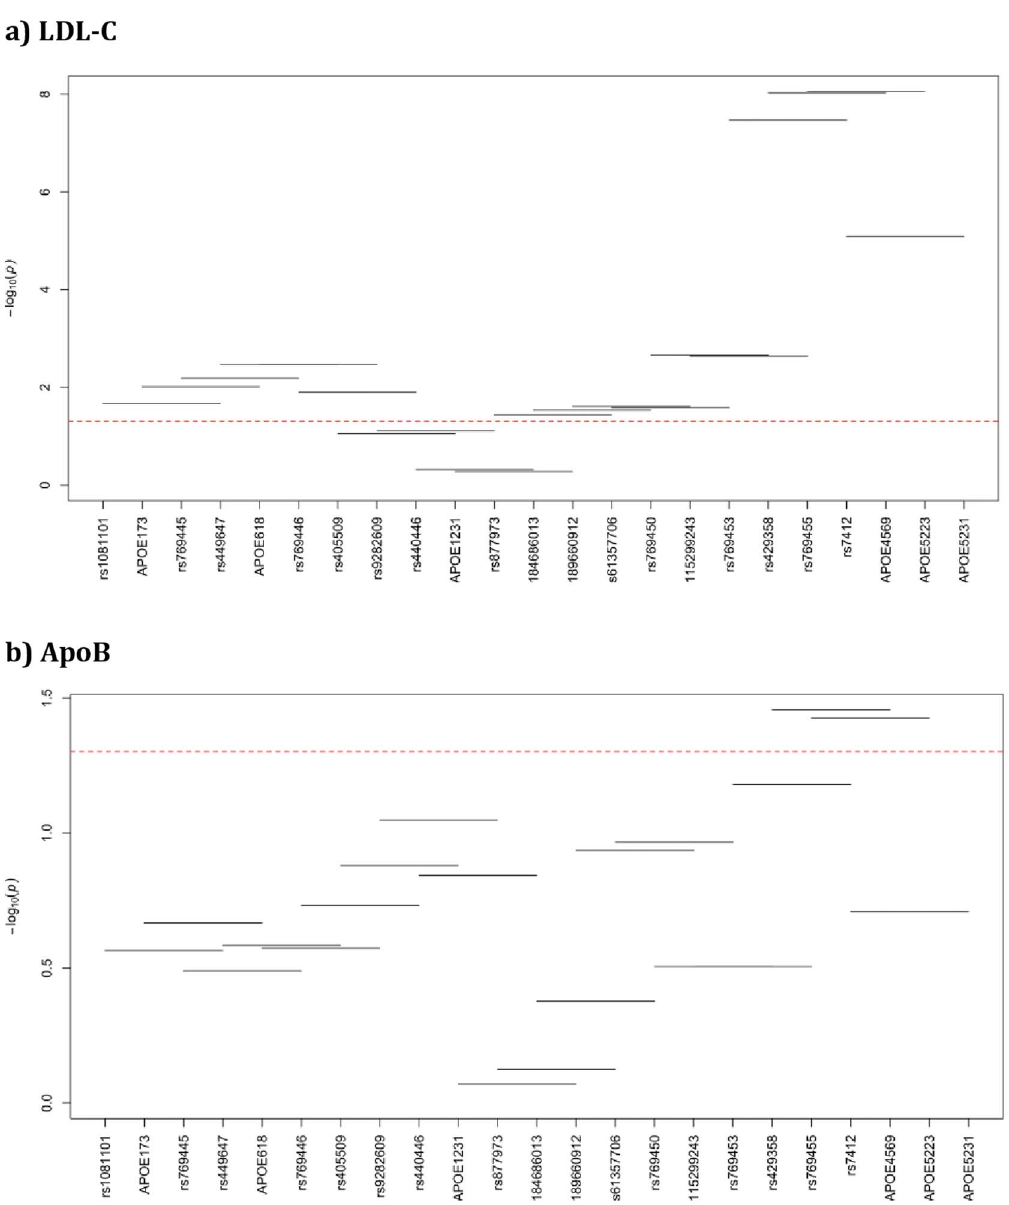
Fig. 4. Haplotype analysis with lipid traits in African Blacks. Haplotype windows for LDL-C ( a ), for ApoB ( b ), for HDL-C ( c ), and for TG ( d ). X-axis has the genotyped markers name and the Y-axis has the –log (global p-value), horizontal lines represent the 4-SNP windows, red-line represents the p-value threshold (p 5 0.05) and everything below the threshold is considered non-significant and vice